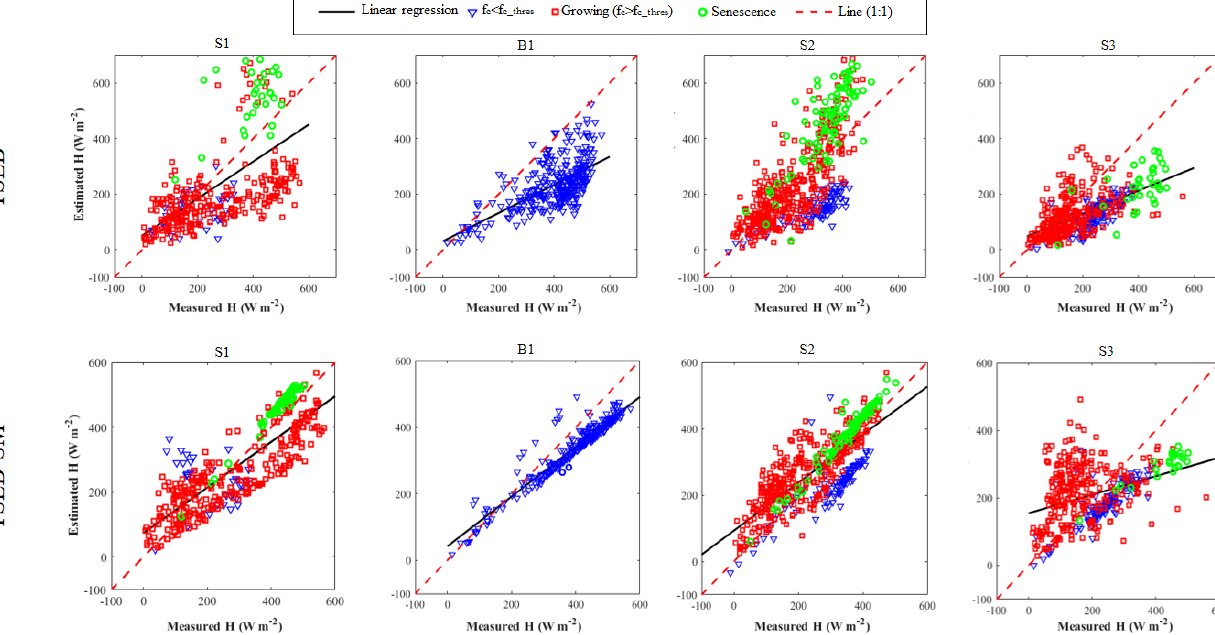
Figure 9. Same as Fig. 8 but for H